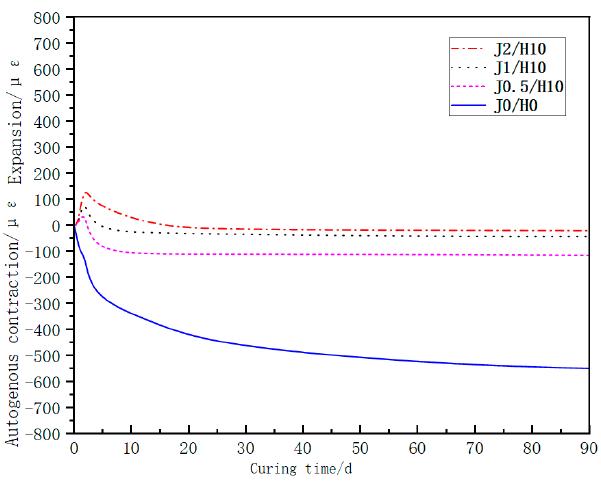
Figure 7. Effect of HPEA and shrinkage-reducing agent on the self-shrinkage of concrete.